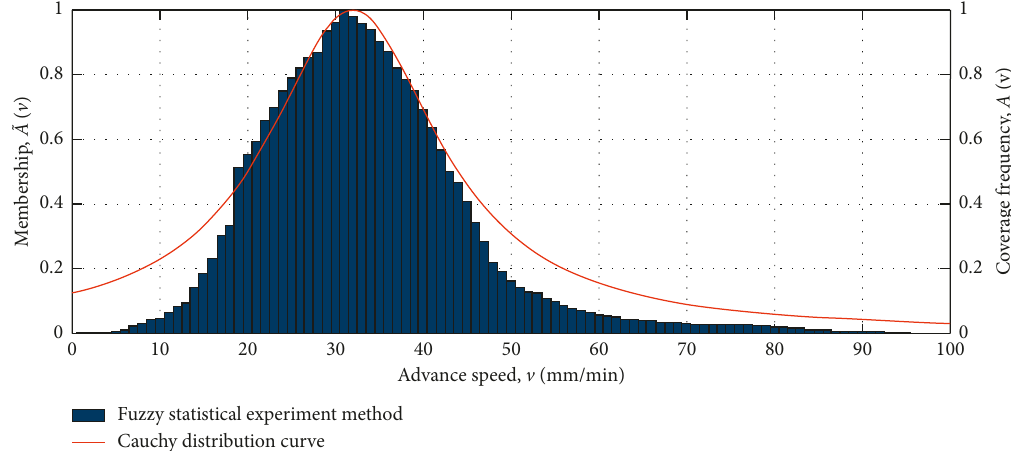
Figure 5: The histogram of membership frequency and the membership function of TBM excavation